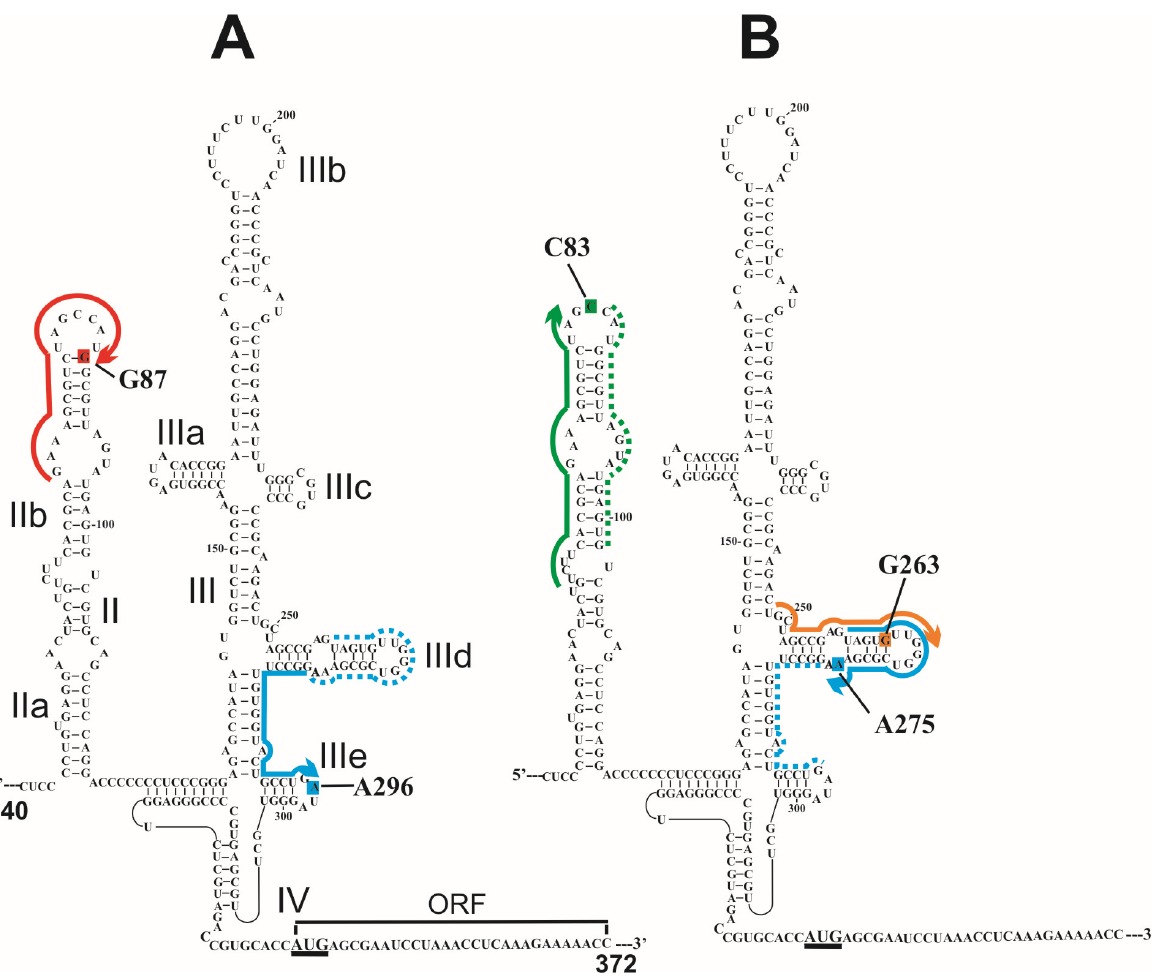
Figure 2. Secondary structure of the HCV IRES [45] (the initiation AUG codon is underlined, and subdomains and open reading frame (ORF) are indicated). RNA sequences complementary to deoxy-oligomers used for site-specific modification of the HCV IRES in [17] ( A ) and in [18] ( B ) are shown with thick lines with arrows indicating the 5'-phosphates derivatized with alkylating groups. RNA sequences complementary to helper oligomers used together with the alkylating derivatives are marked with dotted lines. Nucleotides of the HCV IRES modified with the oligonucleotide derivatives are